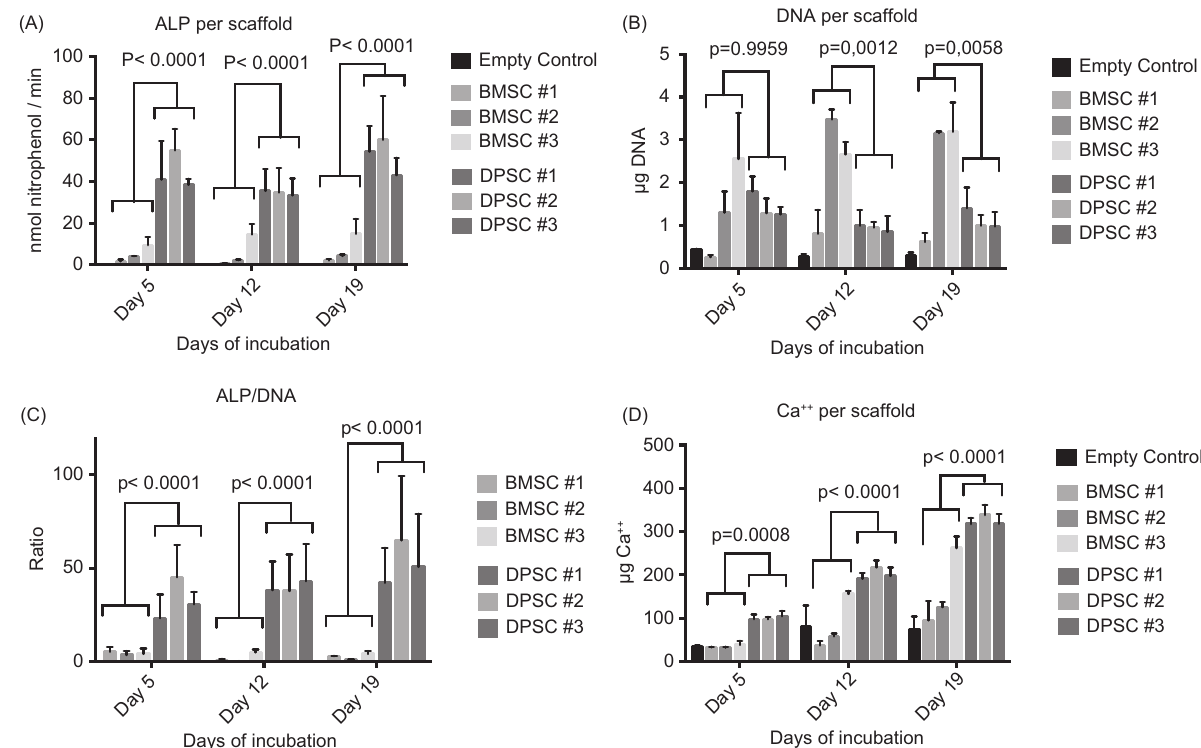
Figure 3. In vitro HT-PCL scaffold seeded with BMSCs or DPSCs. The group mean of the ALP, DNA, and Ca ++ assays as well as ALP/DNA ratio are presented as mean histograms. Error bars represent technical standard deviations and p -values were calculated on combined cell type means. ALP, DNA, and Ca ++ assays were supplemented with a negative empty HT-PCL scaffold control ( n = 4) at all time